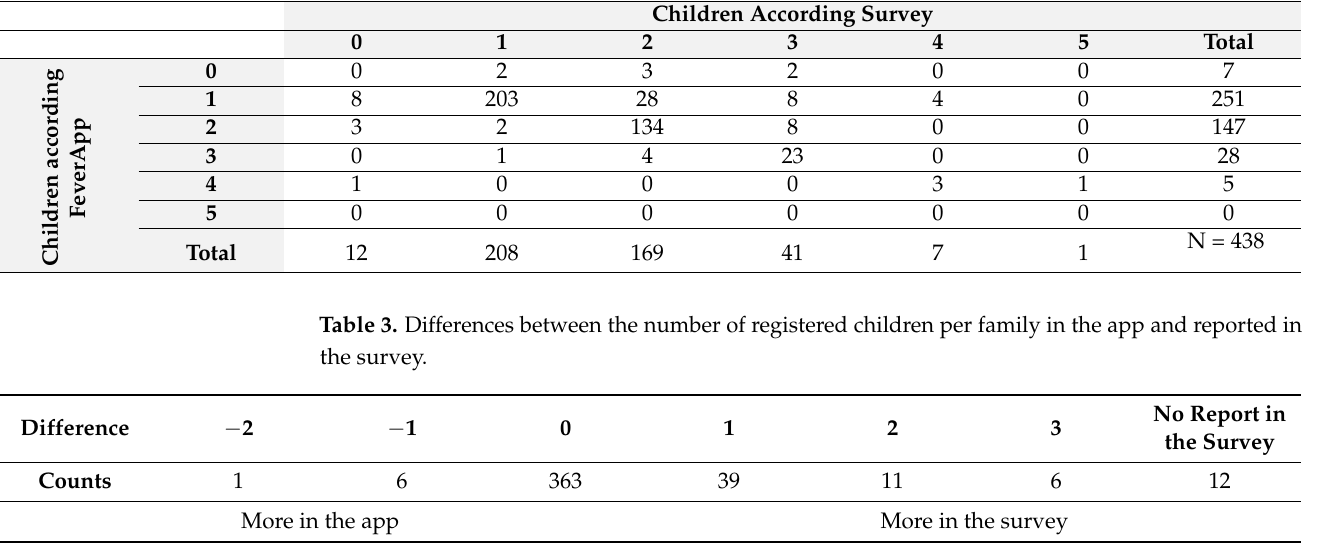
Table 2. Contingency table for the number of children in families.